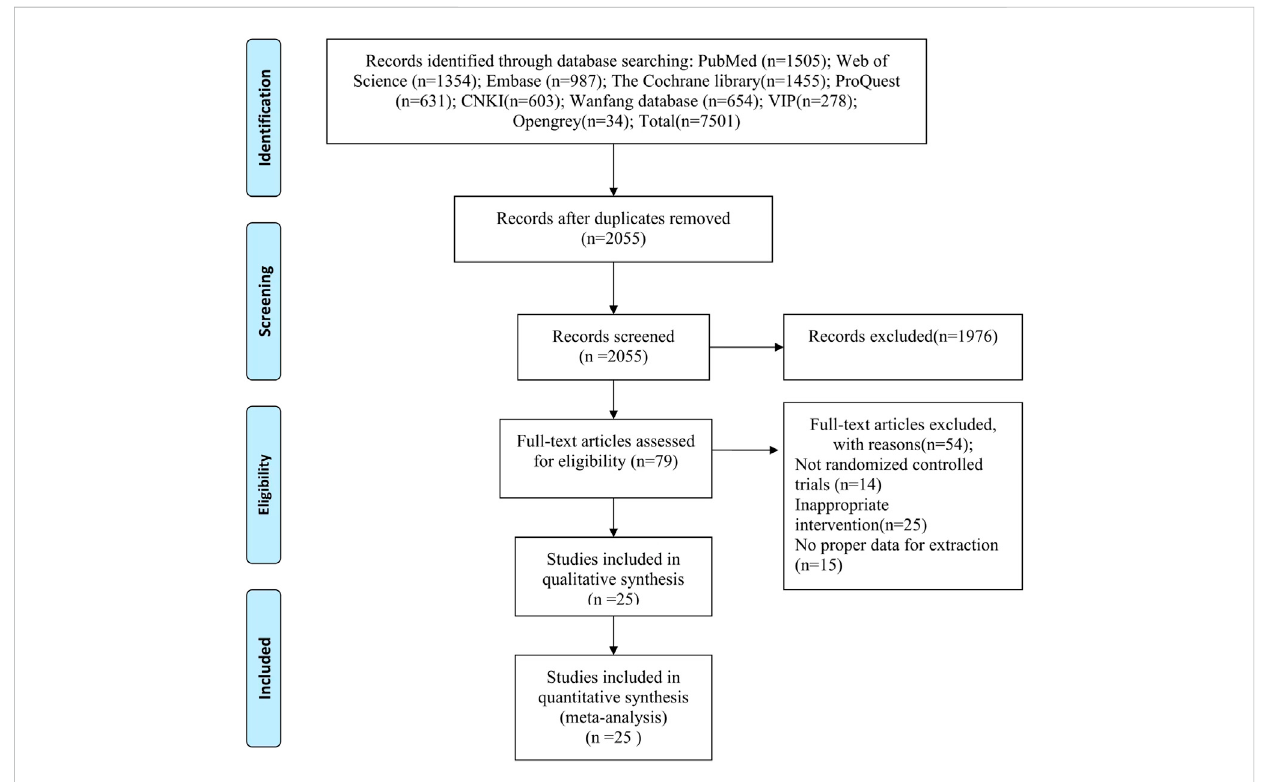
FIGURE 1 Flowchart of the study selection